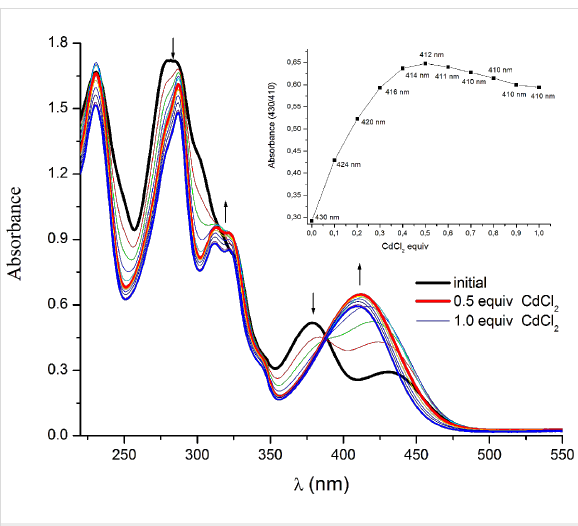
Figure 9: Absorption spectra of a 4.26 mM solution of 4a in methanol upon titration with CdCl 2 aqueous solution (0–1.0 equivalents). Inset shows the visible absorption changes upon cadmium